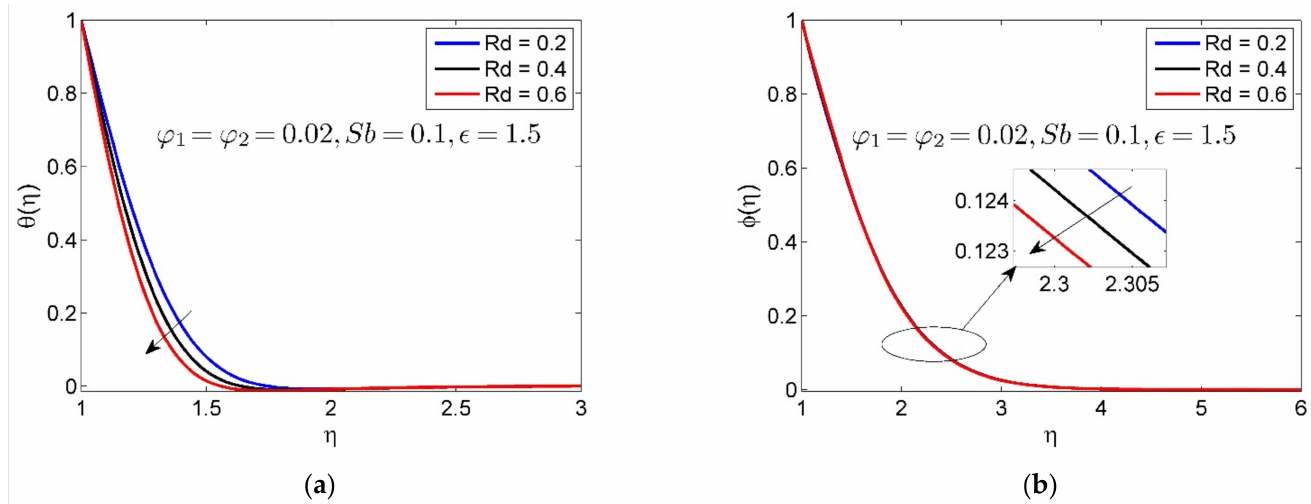
Figure 6. Influences of Rd on θ ( η ) and φ ( η ) .